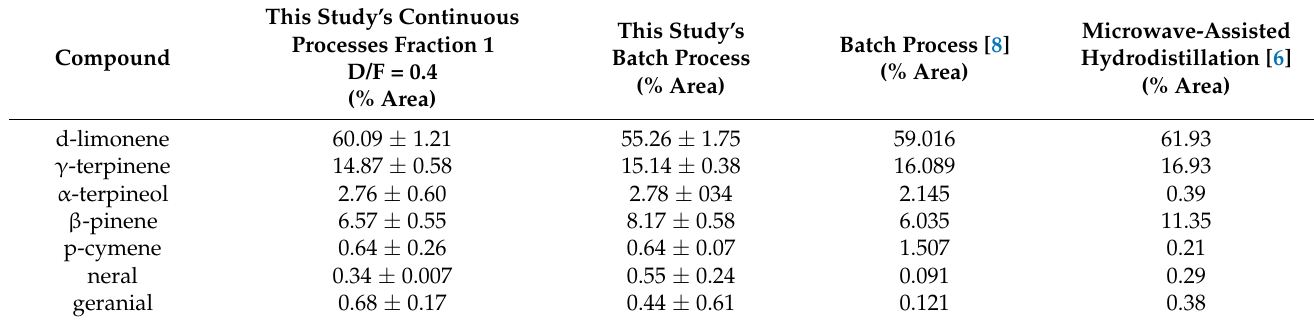
Table 5. Composition of essential oil of Persian lemon by different